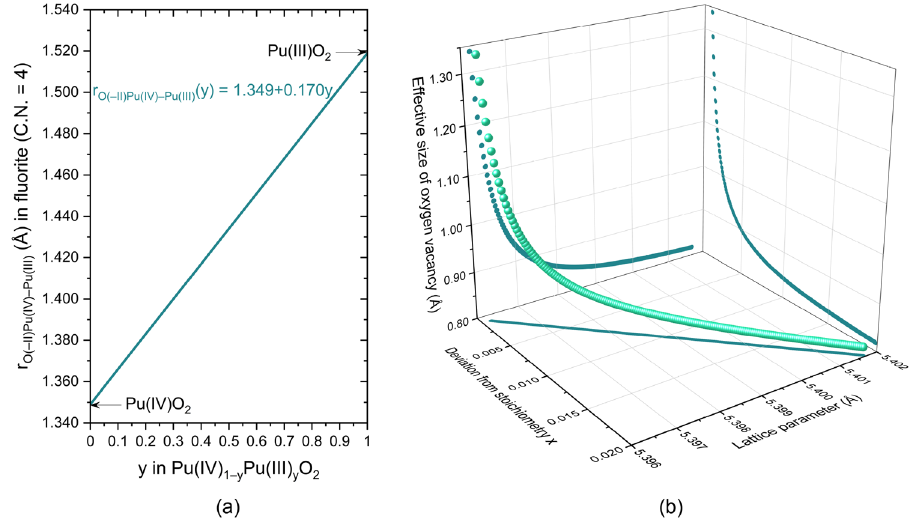
Figure 4. Variations in ( a ) the ionic radius of oxygen, noted r O(–II)Pu(IV)–Pu(III) , as a function of y in the hypothetical Pu(IV) 1−y Pu(III) y O 2 dioxide and ( b ) in the effective size of the oxygen vacancy as a function of the deviation from stoichiometry and the lattice parameter of PuO 2−x at room temperature. N.B. x was only set up to 0.02 because PuO 1.98 is the more reduced composition plutonium dioxide can reach without changing its structure at room temperature, i.e., without forming a second